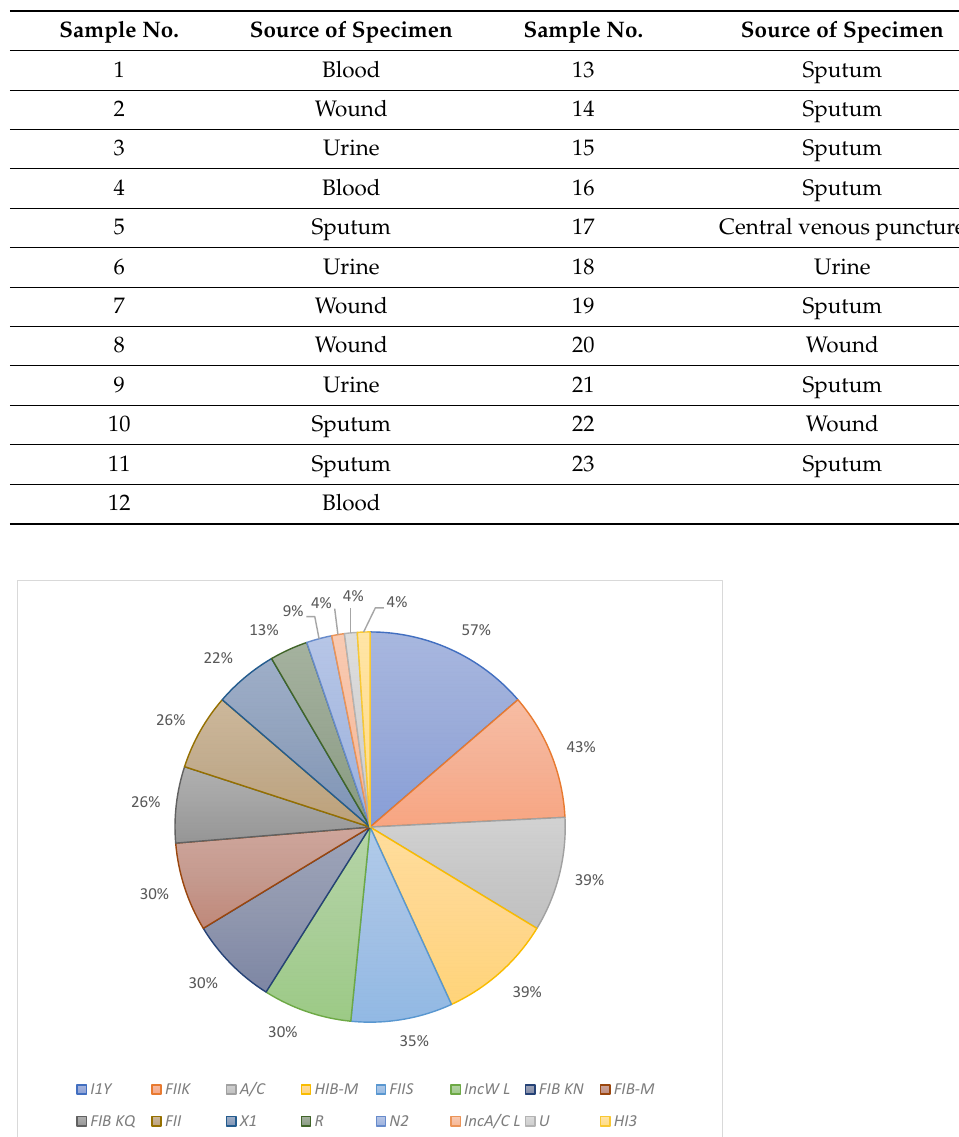
Figure 1. The percentage of replicons in K. pneumoniae KPC isolates.